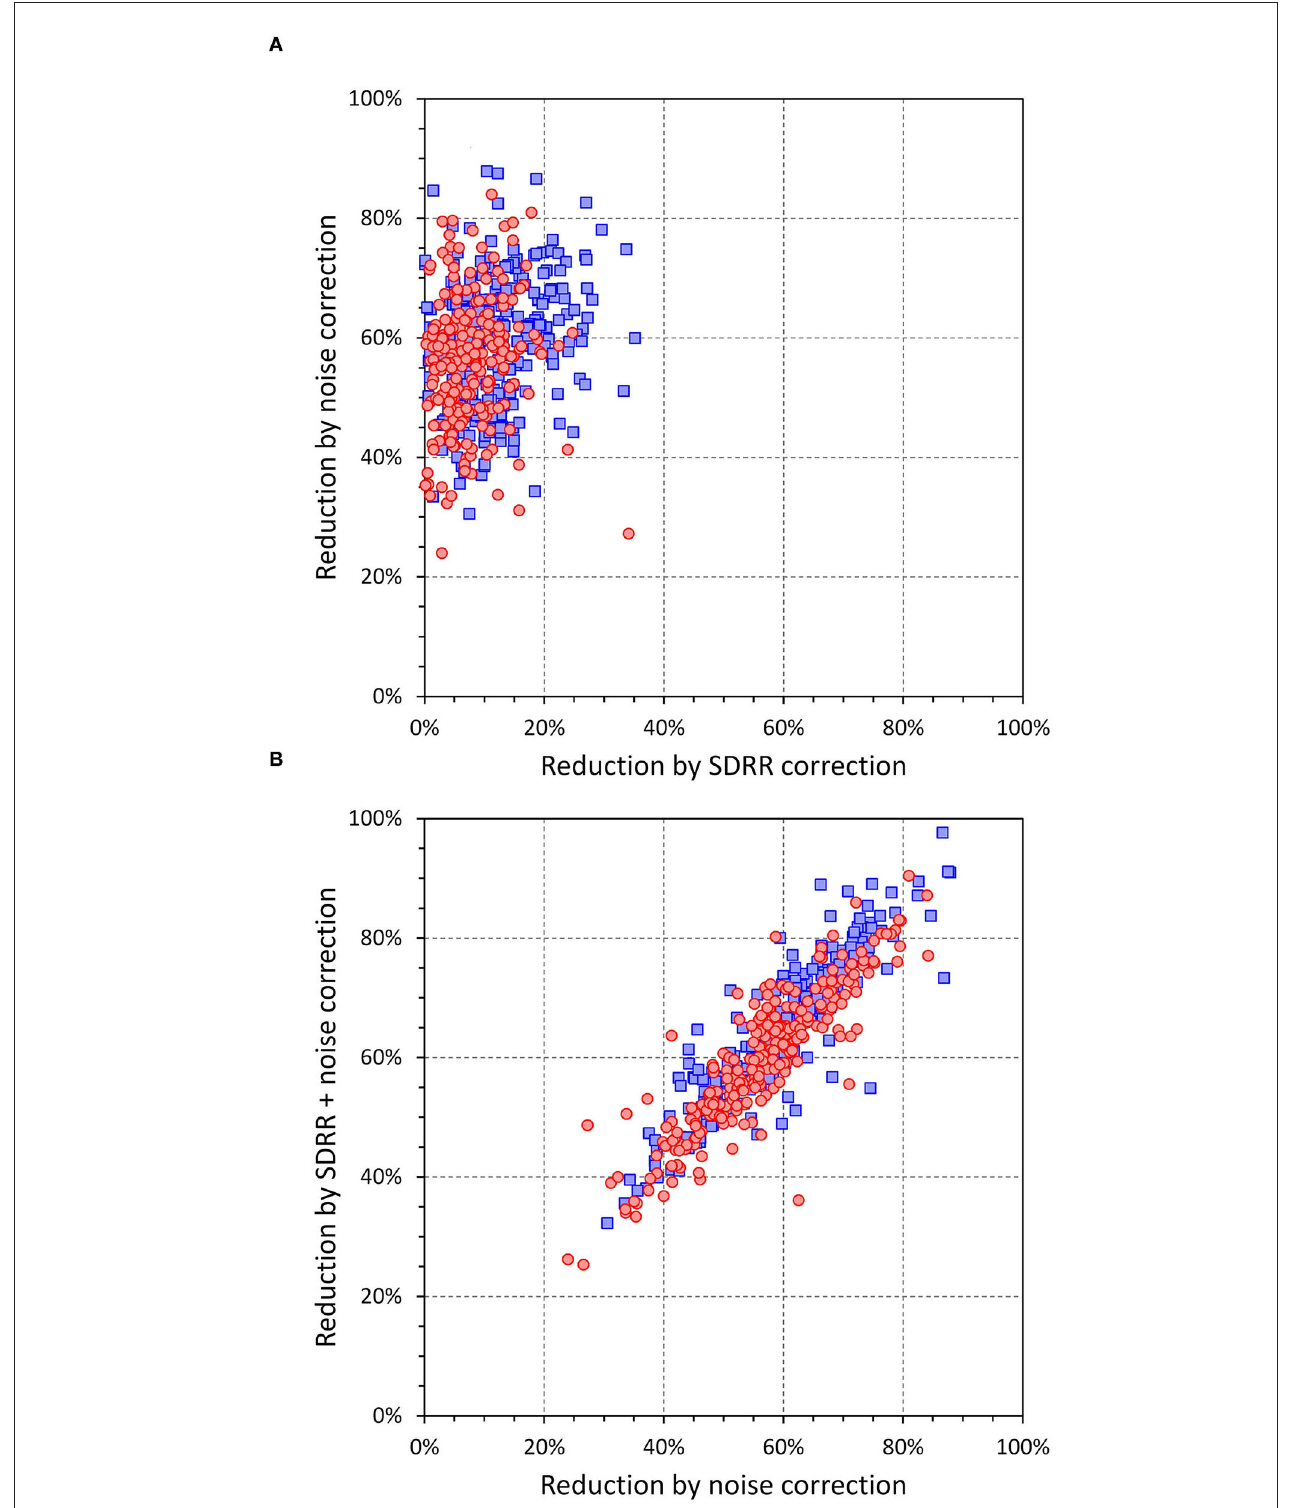
FIGURE 12 | The reduction values shown in this figure are defined as values of relative decrease of intra-subject regression corrected central SDQT values calculated as a proportion of uncorrected intra-subject means of SDQT. The top (A) shows a scatter diagram of the reductions involving regression to SDRR vs. those involving 10-s median beat noise; the bottom (B) shows a scatter diagram of the reductions involving 10-s median beat noise vs. those involving regression to a combination of SDRR and 10-s median beat noise. In both panels, red circles and blue squares correspond to female and males, respectively.